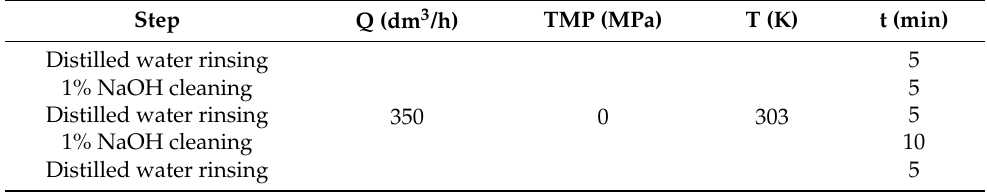
Table 2. Operating conditions for membrane